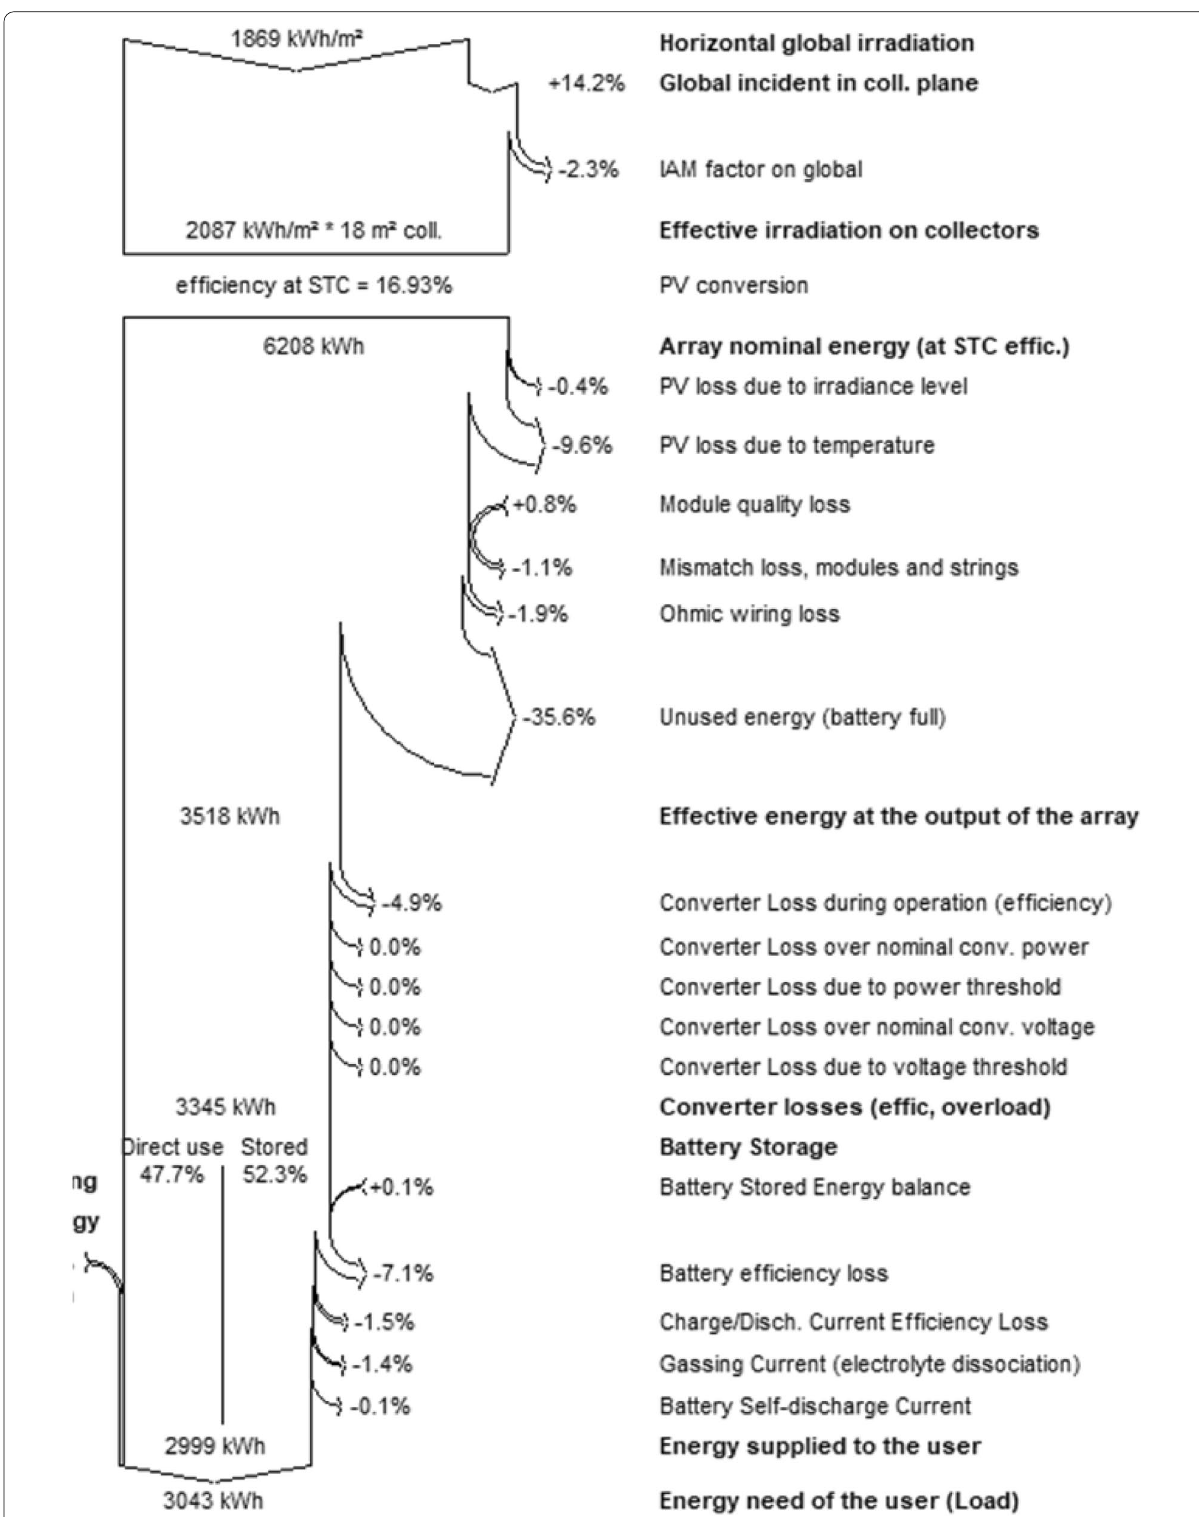
Fig. 9 The arrow loss diagram for the proposed monocrystalline 3kWp stand-alone